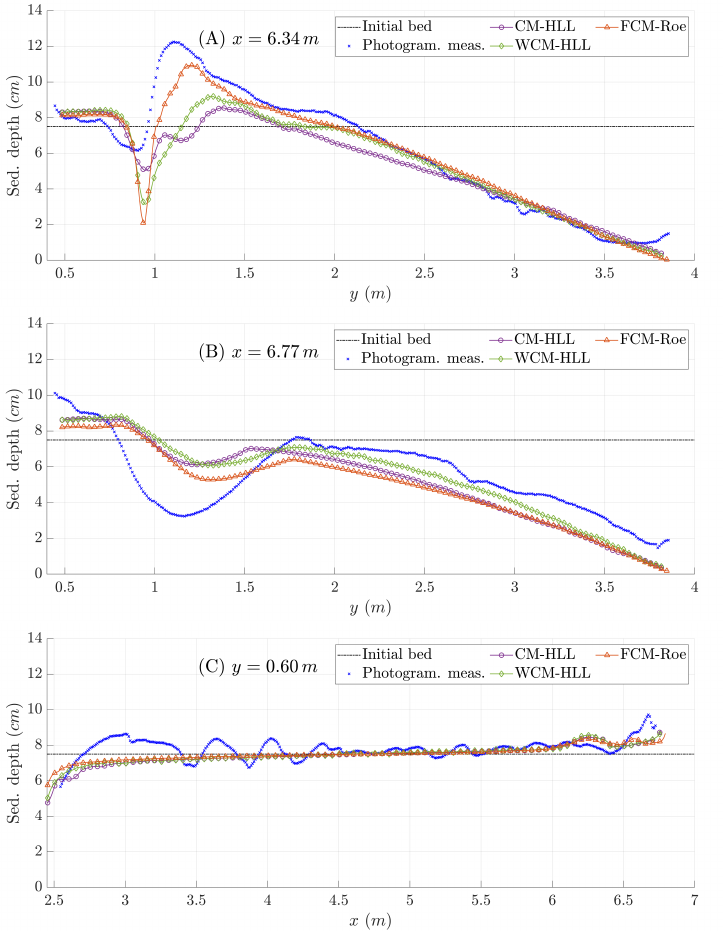
Figure 5. Final bed level profiles along x = 6.34 m ( A ), x = 6.77 m ( B ), and y = 0.60 m ( C ) with the R-Cap, HLLC-CM, and HLLC-WCM. Experimental photogrammetric data are also